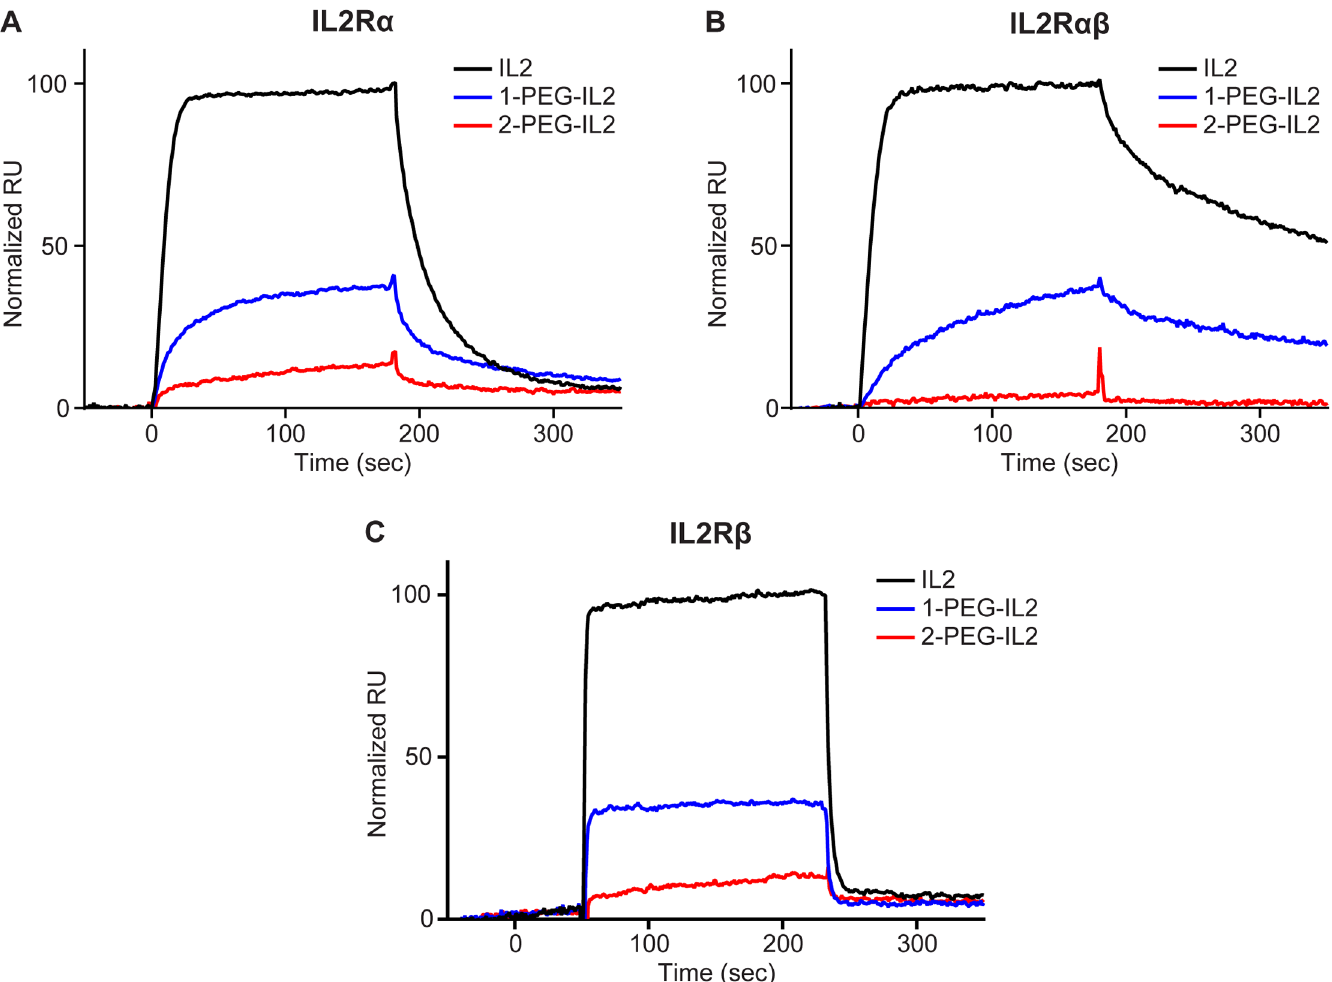
Fig 4. The effect of PEGylation is greatestat the alpha-containing IL2 receptors. Overlay of RU signals normalized by percentage of IL2 response. Each overlaydepicts relative responseof 1-PEG-IL2 and 2-PEG-IL2 at A. IL2R α ,B. IL2R αβ , and C. IL2R β .Representative data are shown for each analyte at a concentration that is near the respectiveIL2 K d concentration per Table